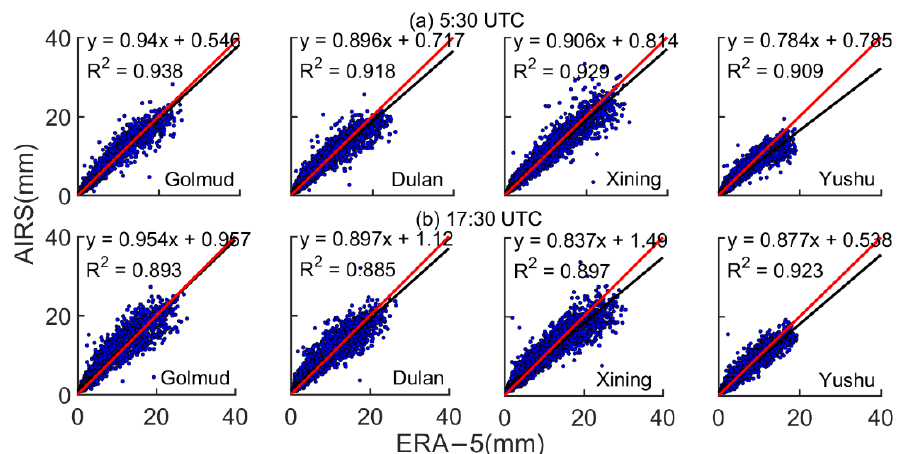
Figure 5. Scattered relationship diagram of PWV from ERA-5 and AIRS data. (black solid line: scatter linear fitting; red solid line: y = x). ( a ) At 5:30 UTC, PWV scattered points were distributed in Dulan, Xining, Golmud, and Yushu stations. ( b ) At 17:30 UTC, PWV scattered points were distributed in Dulan, Xining, Golmud, and Yushu stations.